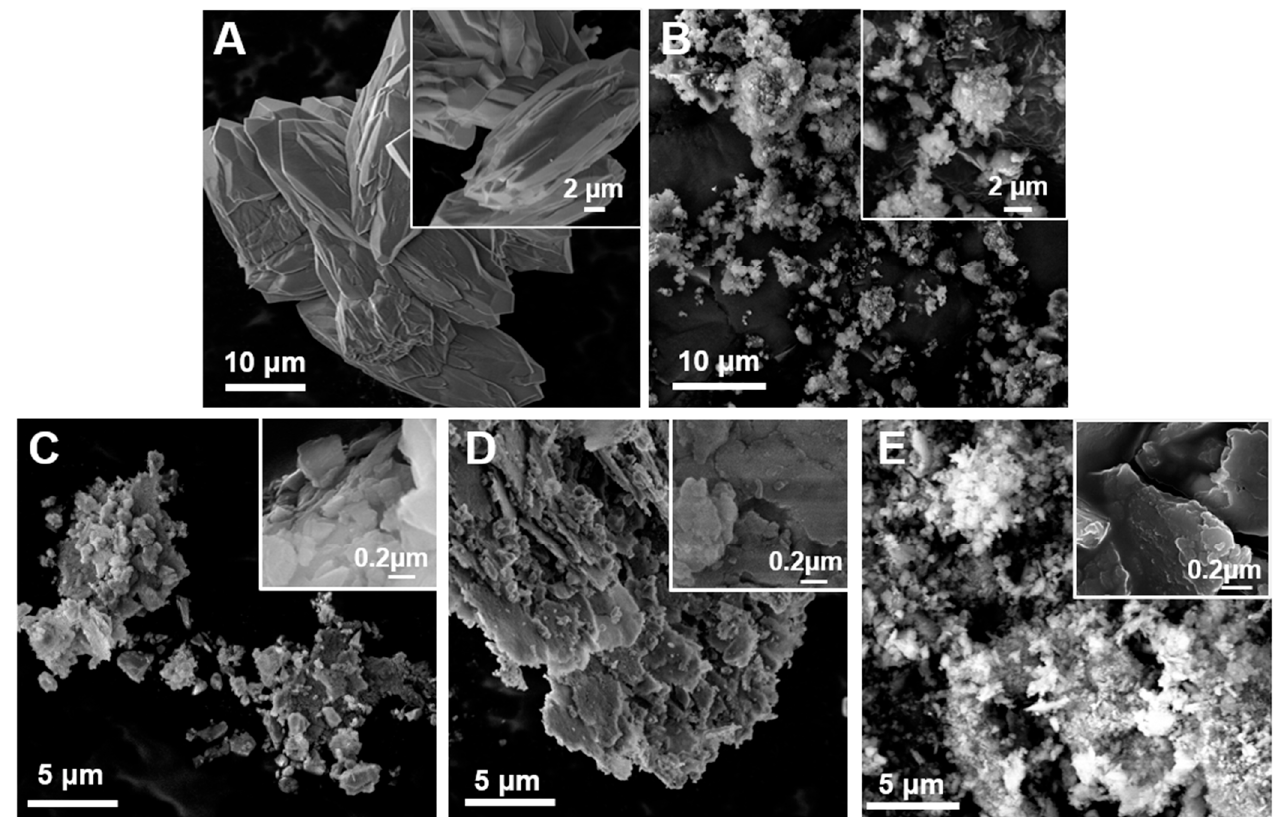
Figure 2. Field emission SEM (FESEM) micrographs at low and high magnification of synthetic as-grown quartz (gQ, ( A )), fine-fractured quartz (gQ-ff, ( B )), and nanoquartz samples (gQ-n1, gQ-n2, and gQ-n3, ( C ), ( D ), and ( E ), respectively) obtained by ball milling.